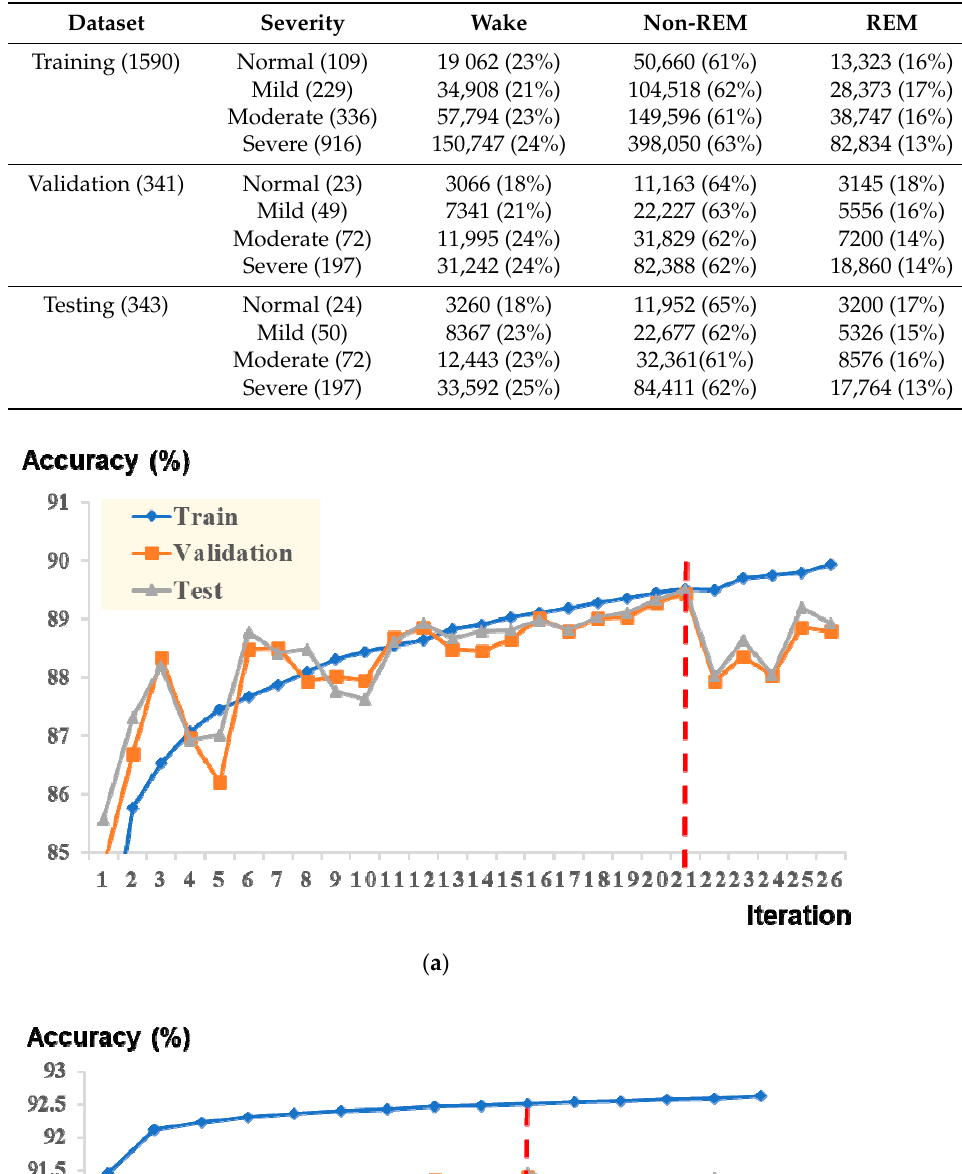
Table 2. Profile of datasets based on the severity of obstructive sleep apnea.